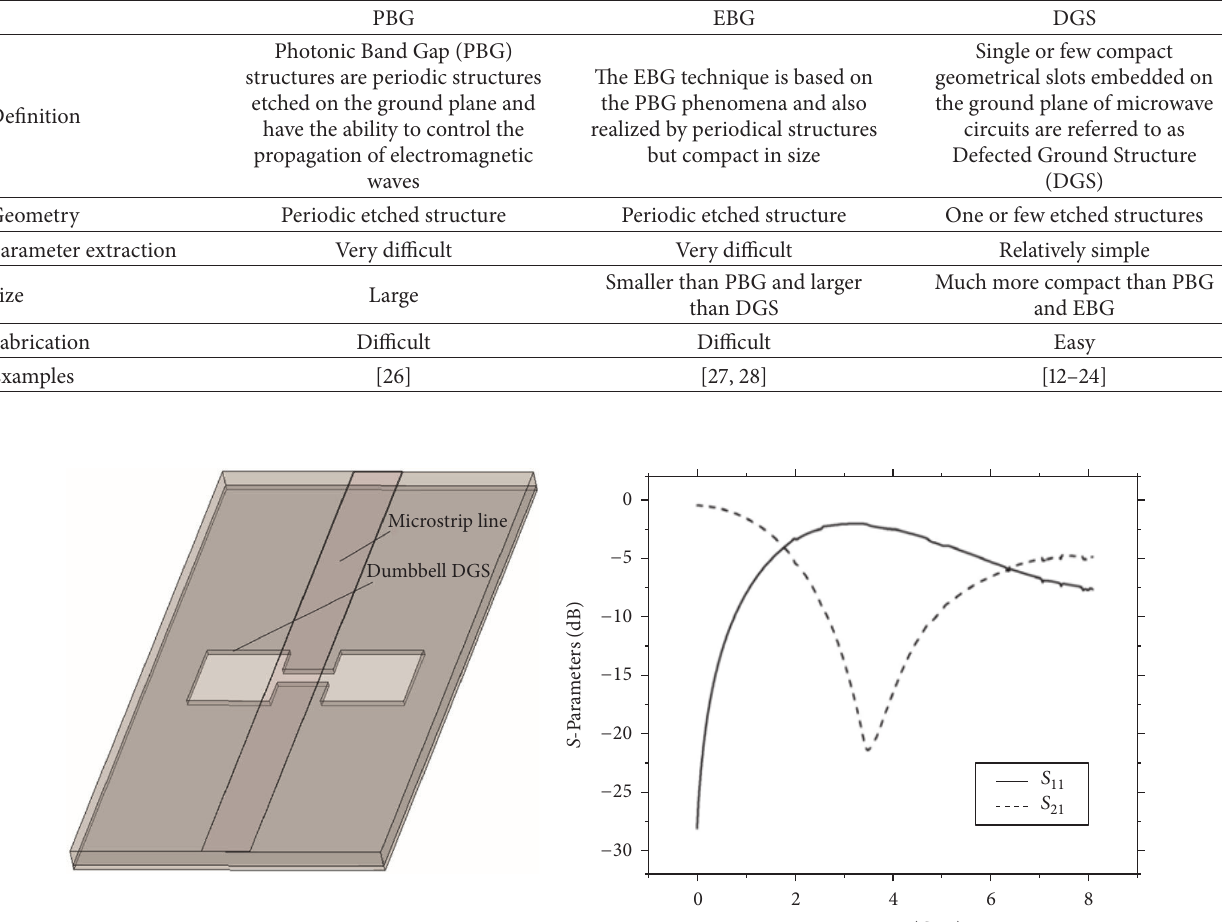
Table 1: Comparison of PBG, EBG, and DGS.